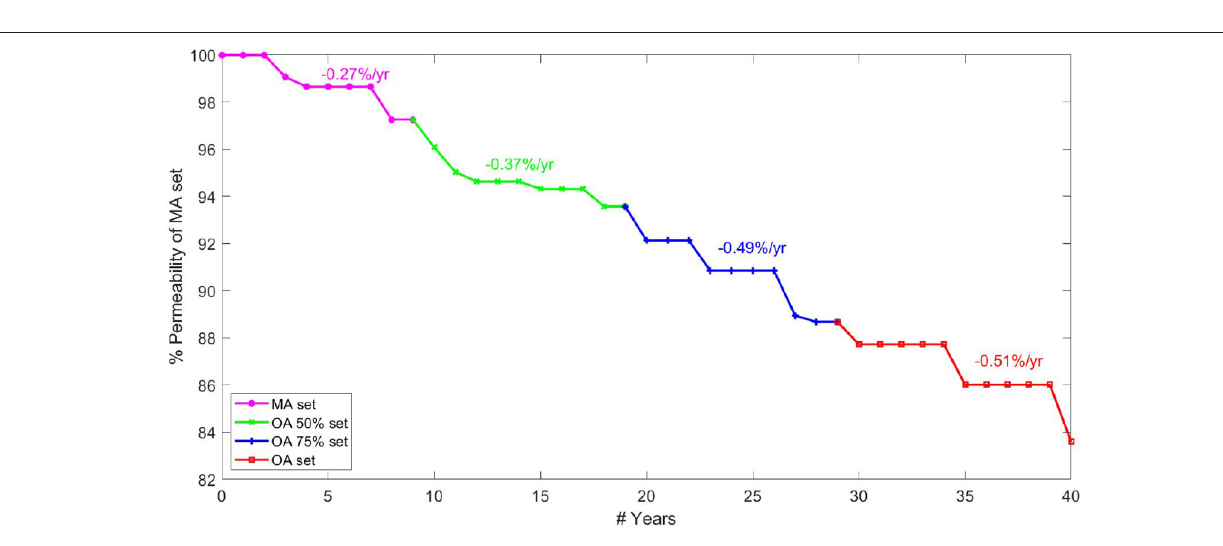
FIGURE 8 | Percentage permeability drop per year in healthy ageing starting from 45 years old ranging up to 85 years